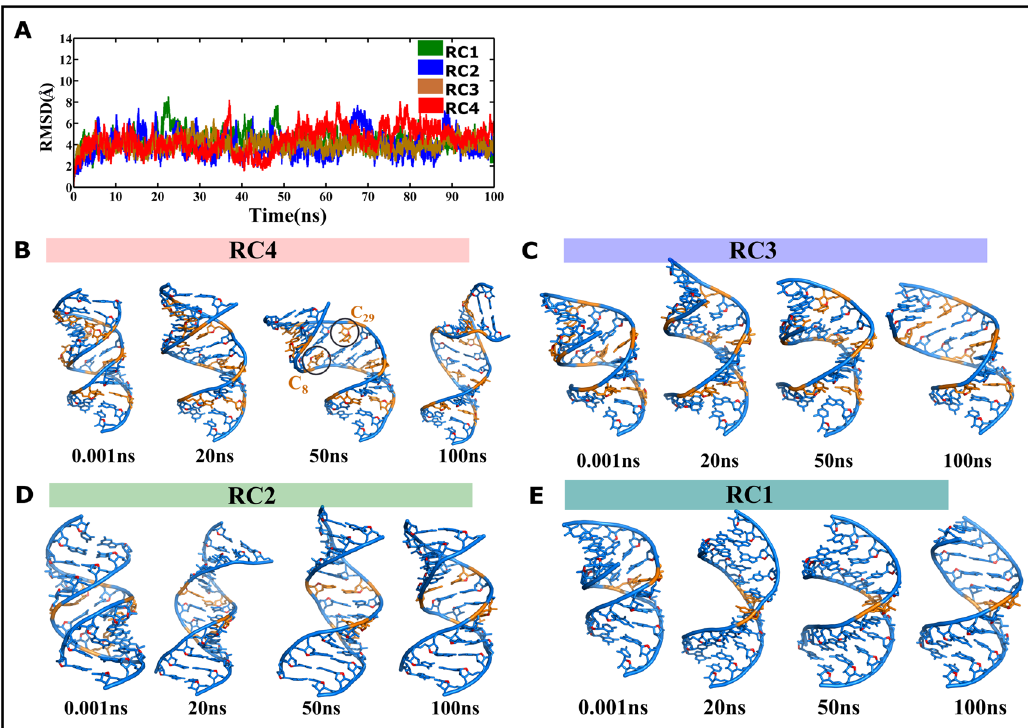
Figure 3. CCG RNA duplexes that contain 1 to 4 C…C mismatches are quite stable. ( A ) Time vs. RMSD profile showing less conformational changes in the RNA duplexes that contain one to four C…C mismatches. This figure was plotted by using MATLAB 7.11.0 software (www. mathw orks. com). Cartoon representation of the snapshots corresponding to (B) RC4 (4 C…C mismatches), ( C ) RC3 (3 C…C mismatches), ( D ) RC2 (2